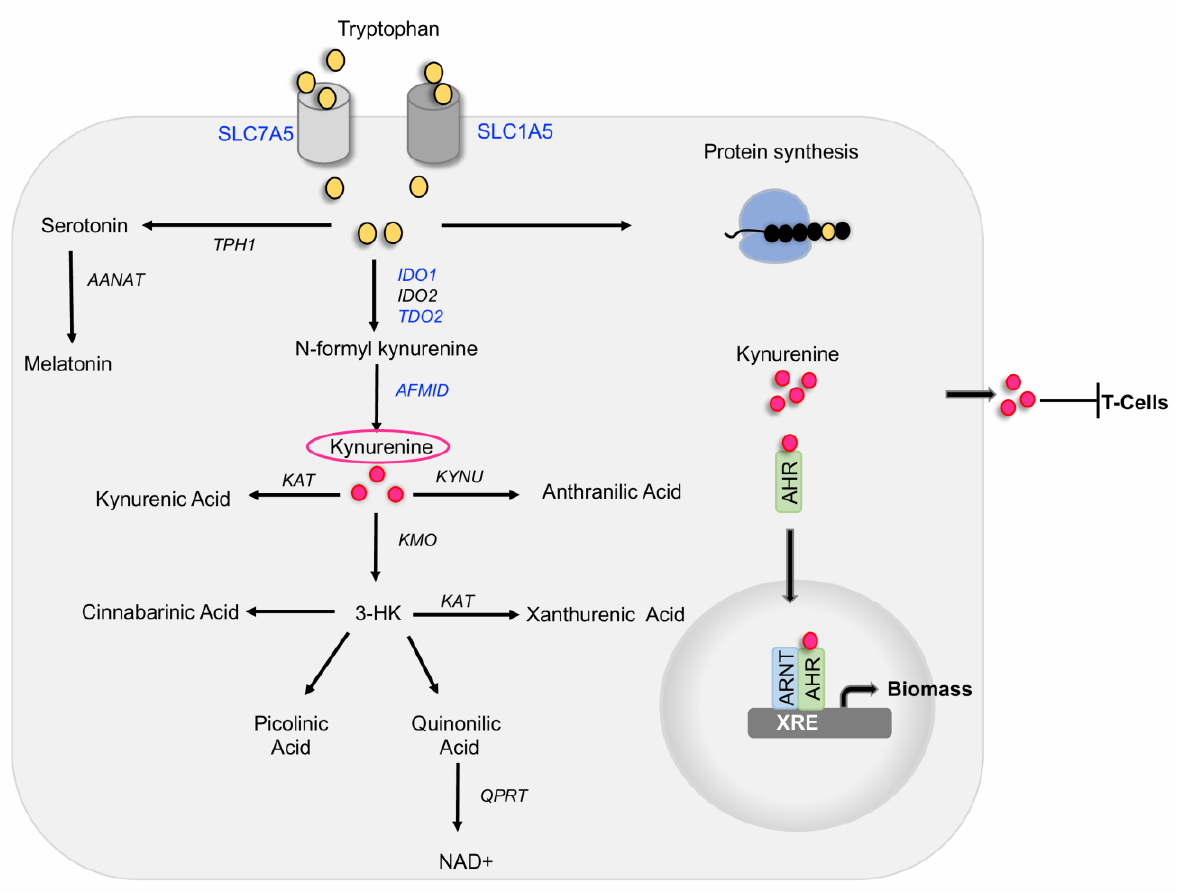
FIGURE 1: Summary of major routes for tryptophan uptake and utilization. Tryptophan is transported by the solute carriers SLC1A5 and SLC7A5. Intracellular tryptophan can be incorporated into proteins or metabolized by the serotonin or the kynurenine pathways. Proteins labelled in blue are transcriptionally upregulated by MYC and as consequence are highly expressed in colon cancer cells. Kynurenine can be exported by cancer cells and cause T-cell inactivation. Intracellular kynurenine binds to and activates the transcription factor AHR, leading to its nuclear translocation. In the nucleus AHR heterodimerizes with ARNT to promote the expression of genes that contain xenobiotic respon- sive elements (XRE) in their promoters, including genes involved in xenobiotic response and a signature of genes that promote protein syn-